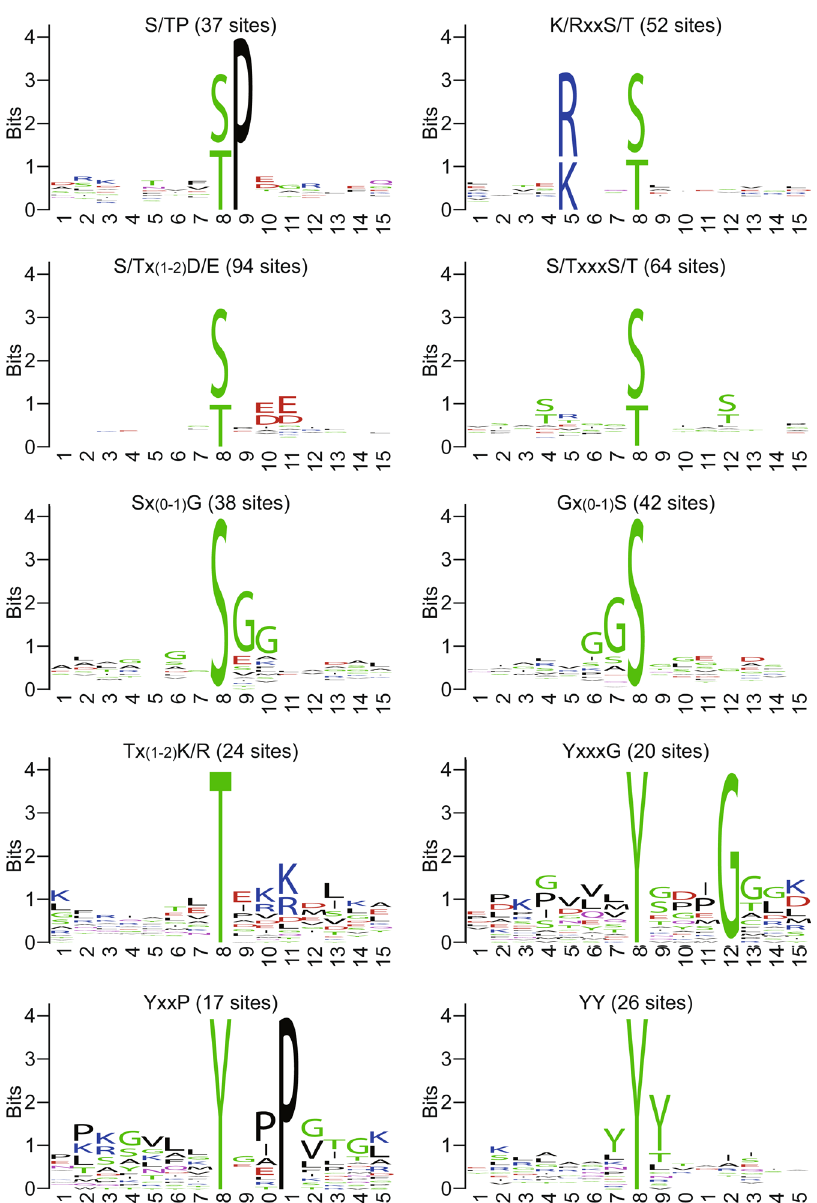
Figure 2. Representative sequence motifs of human proteasome phosphosites. All human proteasome phosphorylation sites were divided into pS, pT, and pY groups and their adjacent sequences were separately analysed with Motif-All. Similar motifs were combined and sequence logos of the ten most abundant representatives are shown. The X-axis shows amino acid positions with the phosphosites in the center. The Y-axis is the information content, which takes into account the frequency of amino acid across the proteome (background frequency) and is therefore a better